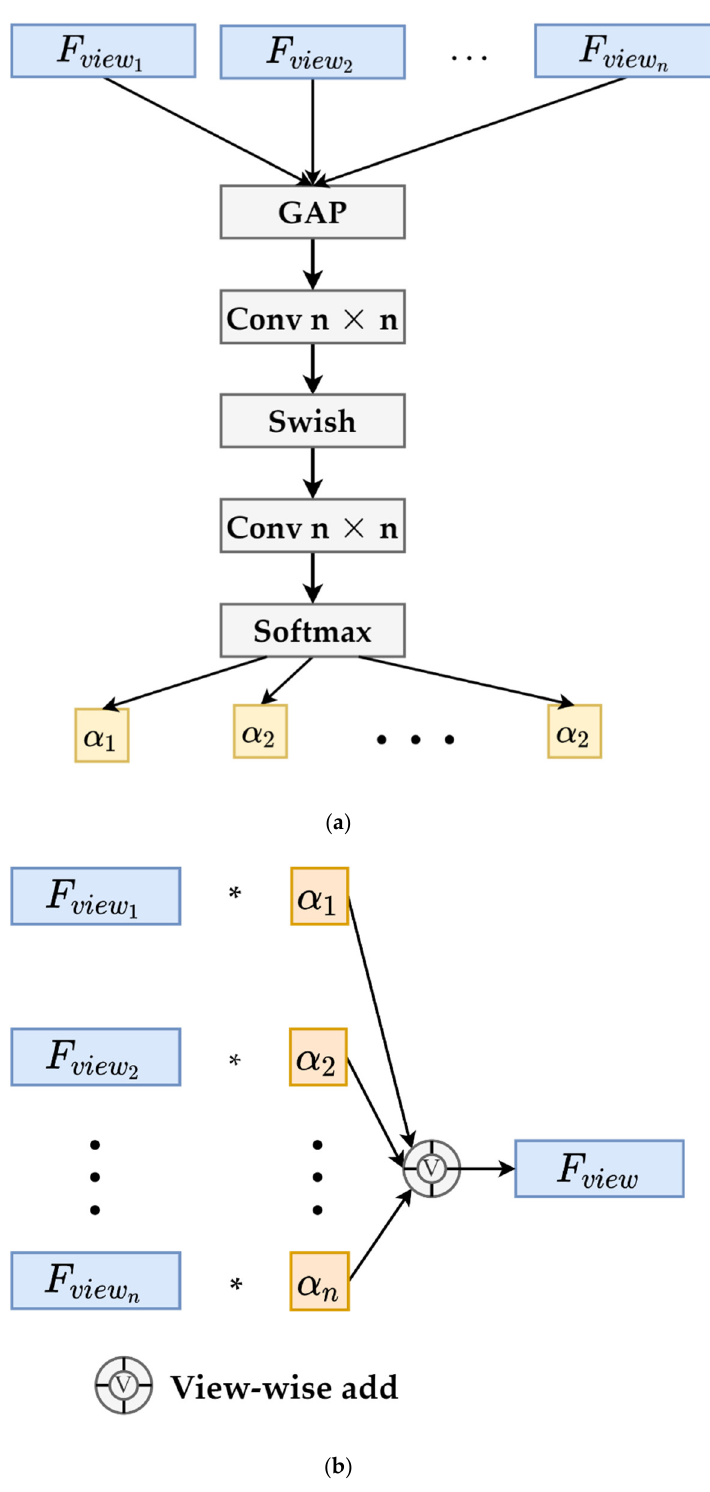
Figure 6. Adaptive attention pooling. ( a ) Dynamic weight generation.( b ) Global views fusion.